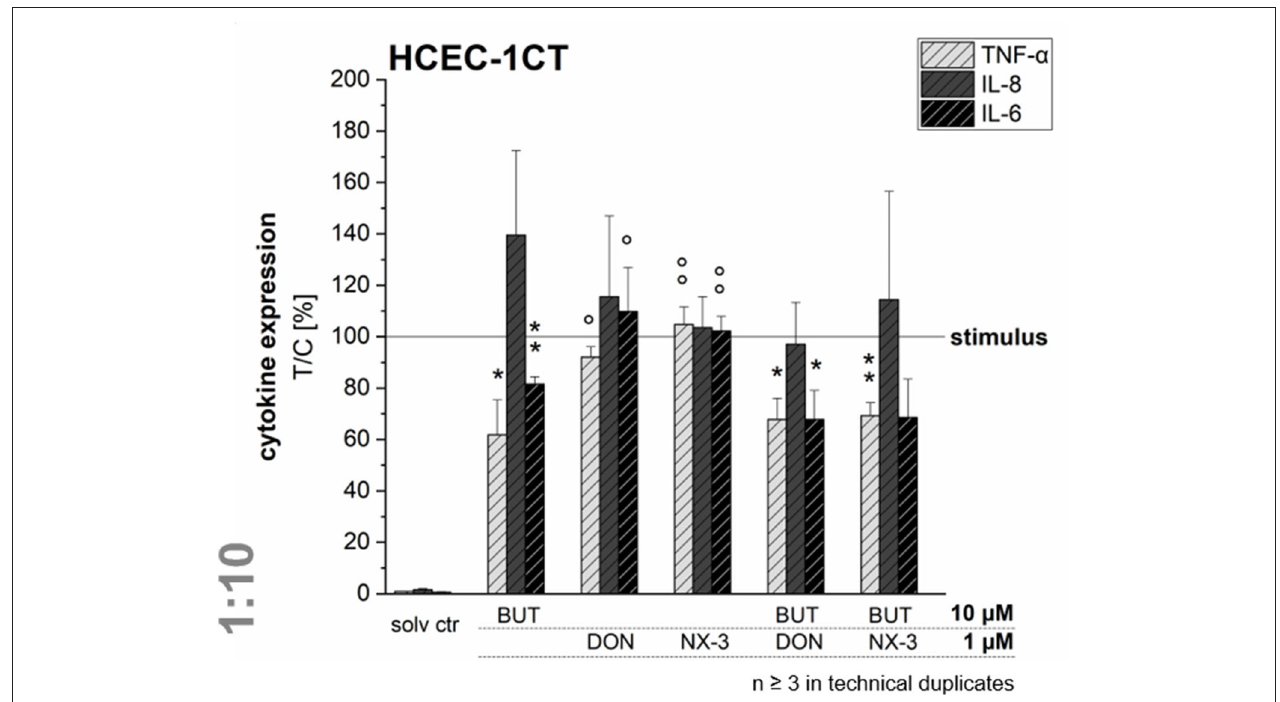
FIGURE 5 | Cytokine expression levels of TNF- α , IL-8, and IL-6 in HCEC-1CT cells after 2h pre-incubation with BUT (10 µ M), DON (1 µ M), NX-3 (1 µ M) and respective 10:1 combinations, followed by 3h co-stimulation with IL-1 β (25ng/mL) measured by a Magnetic Luminex ® assay. Cytokine expression data are normalized to the stimulated solvent control levels. Data are expressed as mean values ± SD of at least three independent experiments performed in technical duplicates. Significant differences to the stimulated solvent control are indicated with * p < 0.05 and ** p < 0.01, whereas significant differences of the combinatory data to the respective DON and NX-3 data are indicated with ◦ p < 0.05 and ◦◦ p < 0.01.